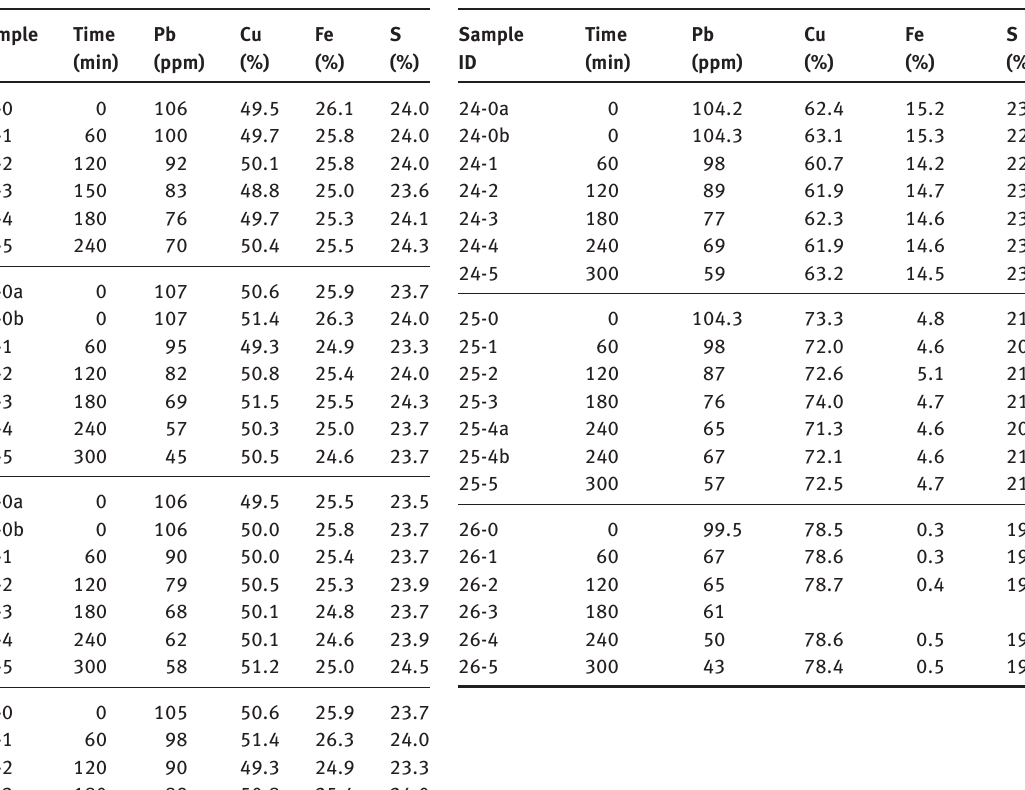
Table 4: Chemistry of the matte samples collected from